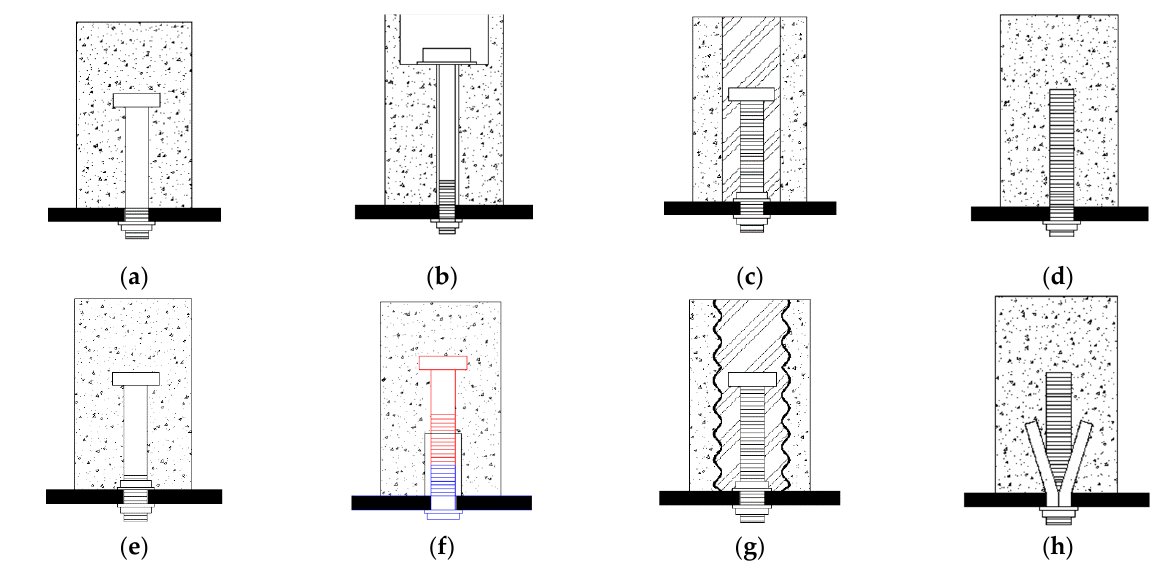
Figure 1. Different types of bolted shear connectors: ( a ) type 1; ( b ) type 2; ( c ) type 3; ( d ) type 4; ( e ) type 5; ( f ) type 6; ( g ) type 7; ( h ) type 8.